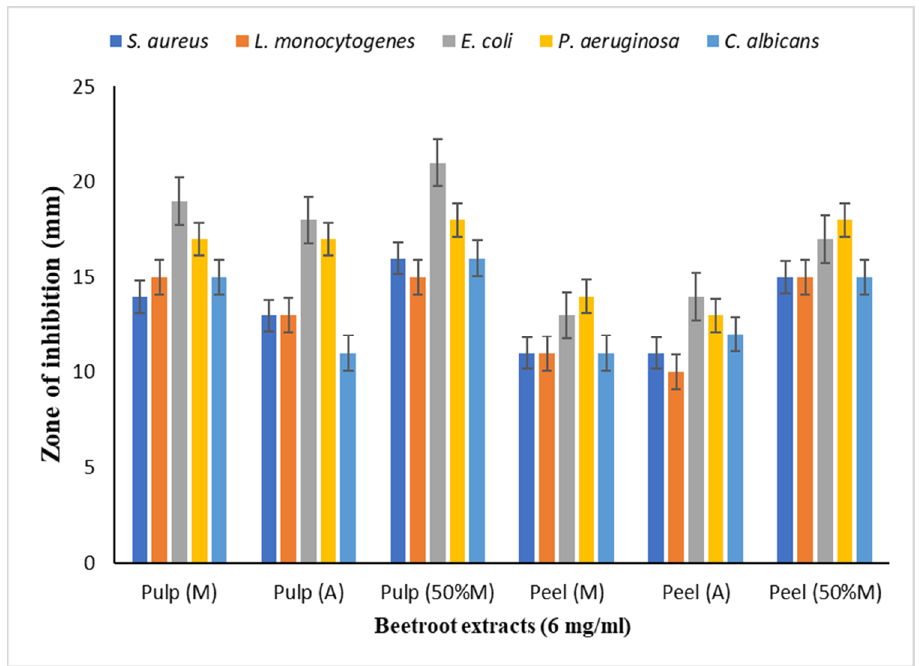
Figure 4. Antimicrobial activity of the beetroot extracts. (M), methanol; (A), water; (50% M), 50% methanol. Table 4. Minimum inhibitory concentration (MIC) and minimum bactericidal concentration (MBC) values of beetroot peel and pulp extracts against test pathogens. MIC and MBC values are given in mg/mL.